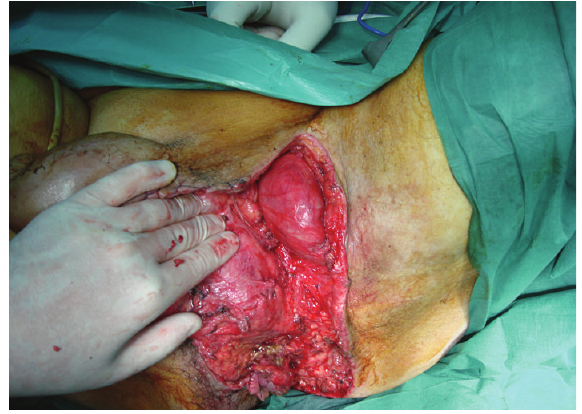
Figure 4: The left testicle is transpositioned into a subcutaneous pocket in the inner side of the left thigh.